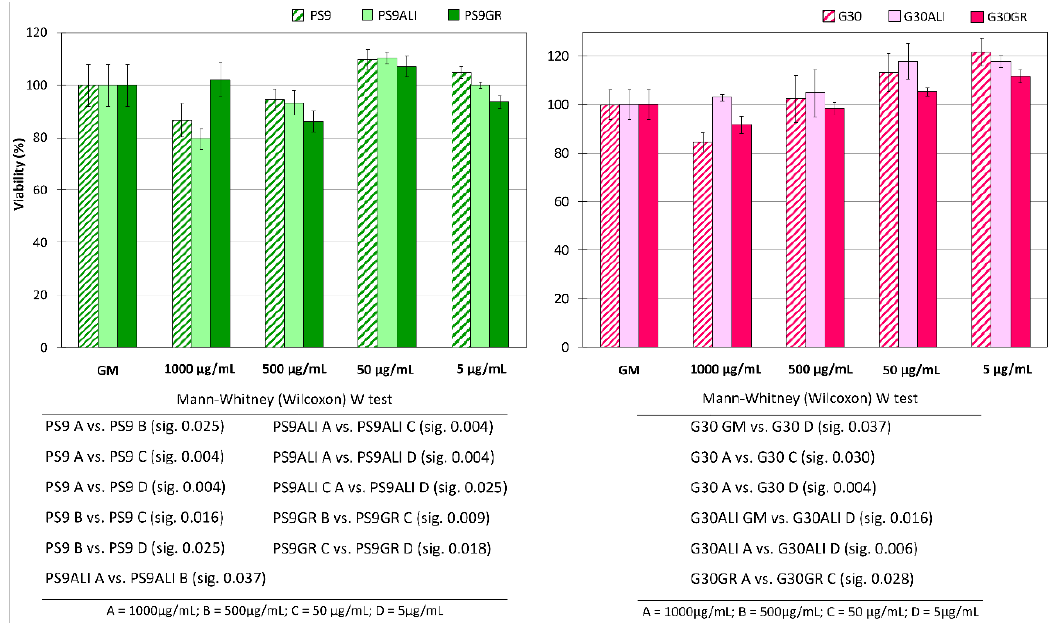
Figure 4. Biocompatibility tests (contact time 24 h) of PS9, PS9ALI and PS9GR (left) and G30, G30ALI and G30GR (right). Viability (%) vs. clay concentrations toward NHDF. GM stands for “growth medium” and refers to control test. Mean values ± s.d.; n = 8. Significant differences were reported within the figure (down) as “sig” which refers to “ p -values”.